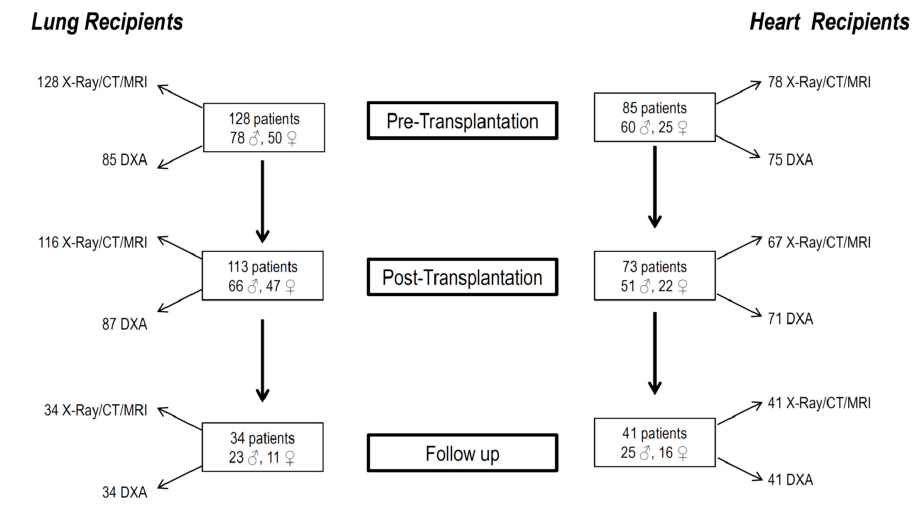
Figure 1. Flowchart showing patient enrollment and follow-up.